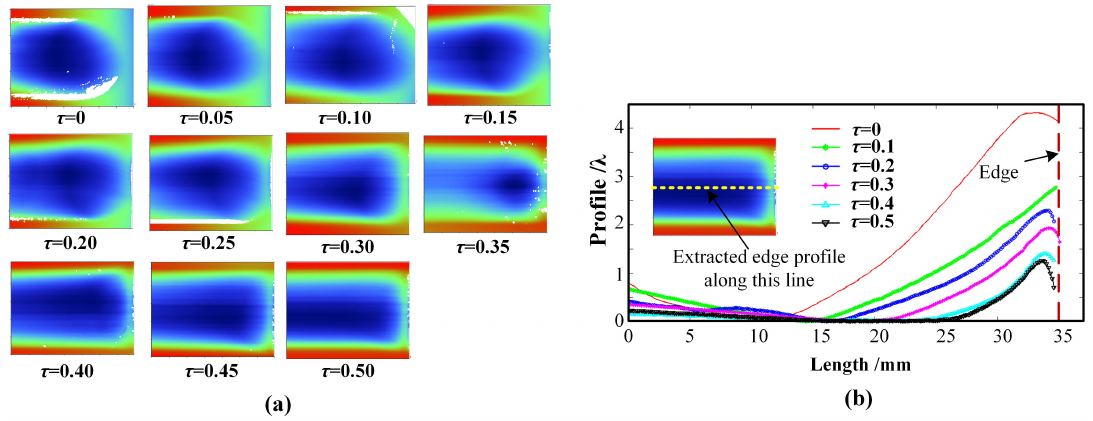
Figure 6. Experiment results of each polishing line. ( a ) removed form shape of each polishing line and ( b ) extracted sectional profiles of them. ( λ = 632.8